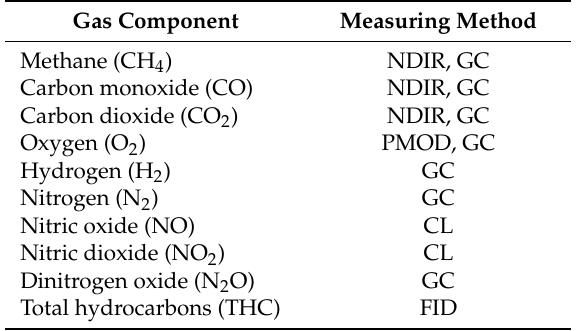
Table 3. Overview of measured gas components and instrumentation. NDIR = Non-Dispersive Infrared Sensor, GC = Gas Chromatography, PMOD = paramagnetic oxygen detector, CL = Chemiluminescence, FID = Flame Ionization